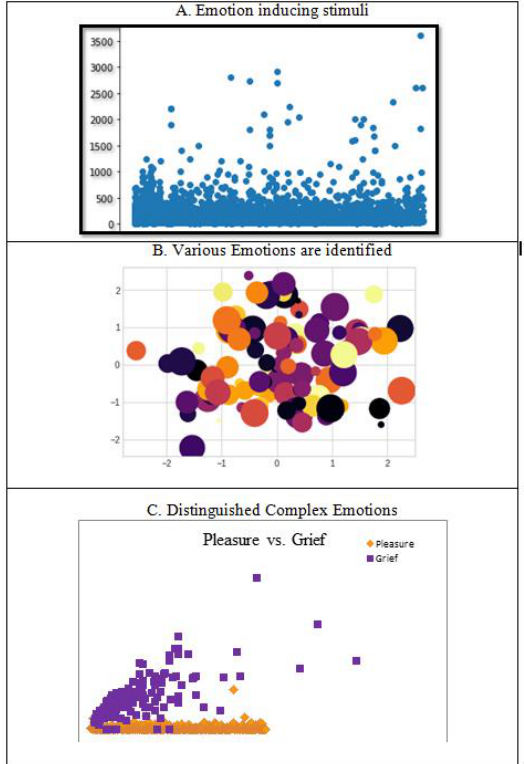
Figure 7. The emotions induced by the stimulus to which participants were exposed have three different classifications of complex emotions. different classifications of complex